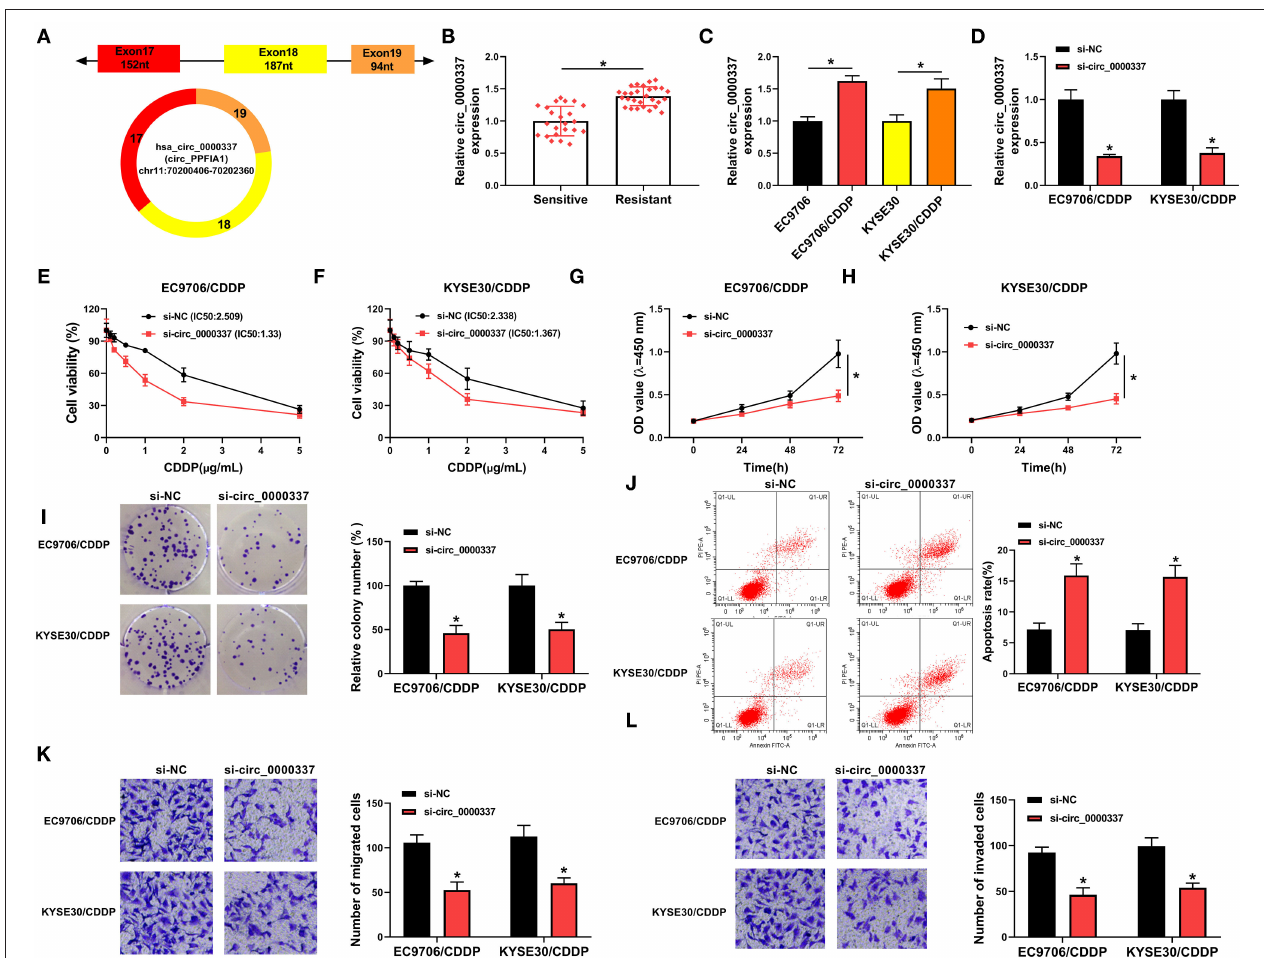
FIGURE 2 | Circ_0000337 knockdown decreased CDDP resistance in esophageal cancer cells. (A) Schematic illustration of circ_0000337 was exhibited. (B) RT-qPCR assay was used to examine the expression level of circ_0000337 in the chemosensitive group ( n = 23) and the chemoresistant group ( n = 29). (C) Circ_0000337 level was detected in EC9706, EC9706/CDDP, KYSE30, and KYSE30/CDDP cells. ( D–L ) EC9706/CDDP and KYSE30/CDDP cells were transfected with si-NC or si-circ_0000337. (D) Relative circ_0000337 expression was tested in transfected EC9706/CDDP and KYSE30/CDDP cells. (E,F) Cell viability and IC50 values were detected in transfected EC9706/CDDP and KYSE30/CDDP cells. (G–I) Cell proliferation and colony number were assessed in transfected EC9706/CDDP and KYSE30/CDDP cells. (J) Apoptosis rate was analyzed in transfected EC9706/CDDP and KYSE30/CDDP cells. (K,L) Migration and invasion were measured